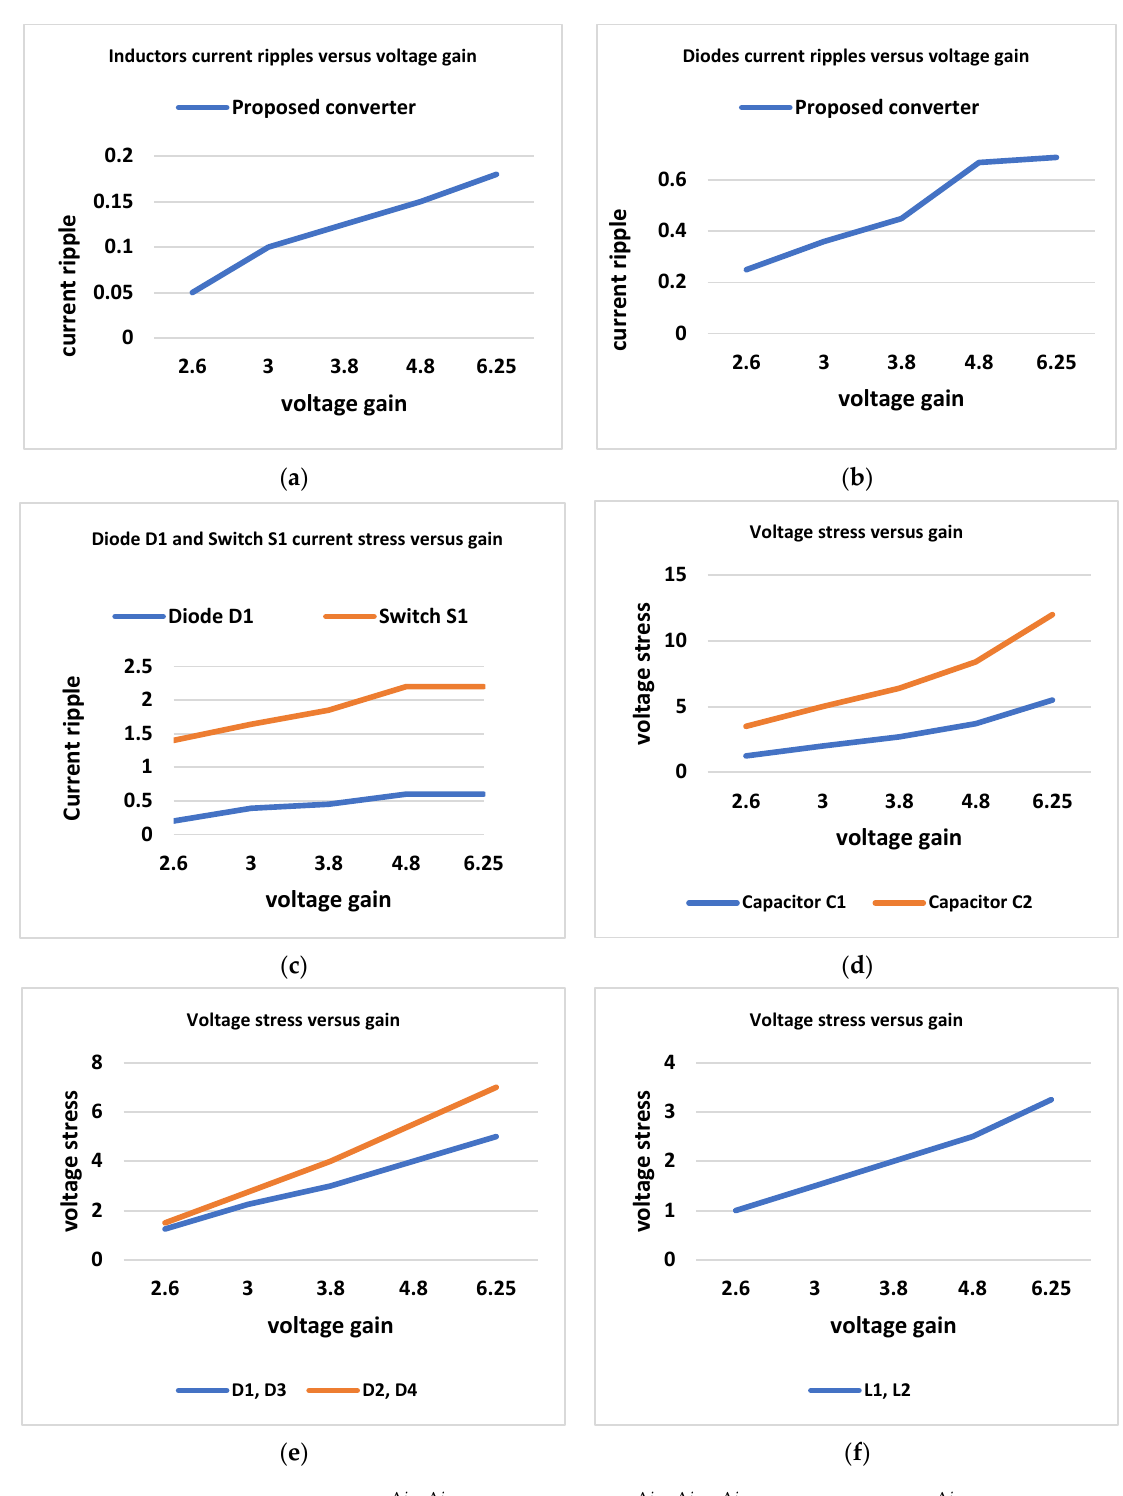
Figure 14. ( a ) ∆𝒊 𝑳𝟏 ,∆𝒊 𝑳𝟐 Figure 14. ( a ) versus gain; ( e ) sus gain; ( e ) ∆𝒗 𝑫𝟏 ,∆𝒗 𝑫𝟐